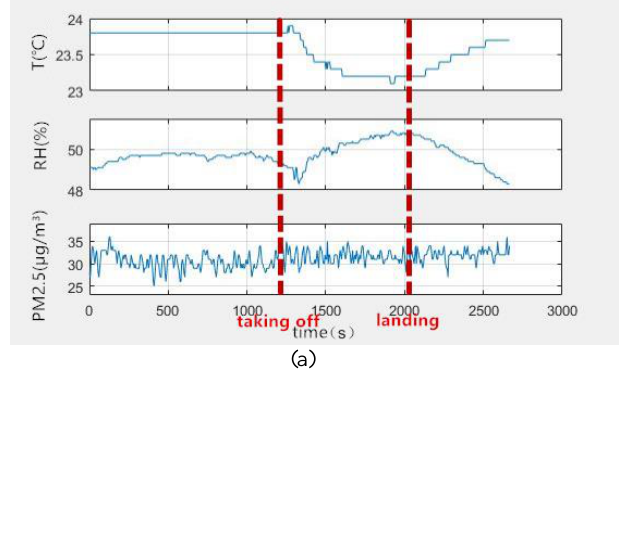
Figure 5 Detector data measured at different placement